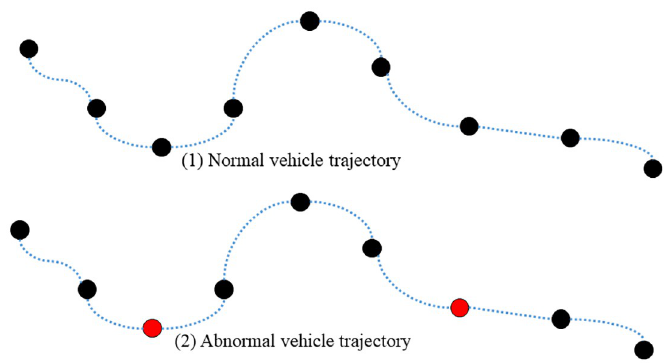
Fig 3. Vehicle trajectory